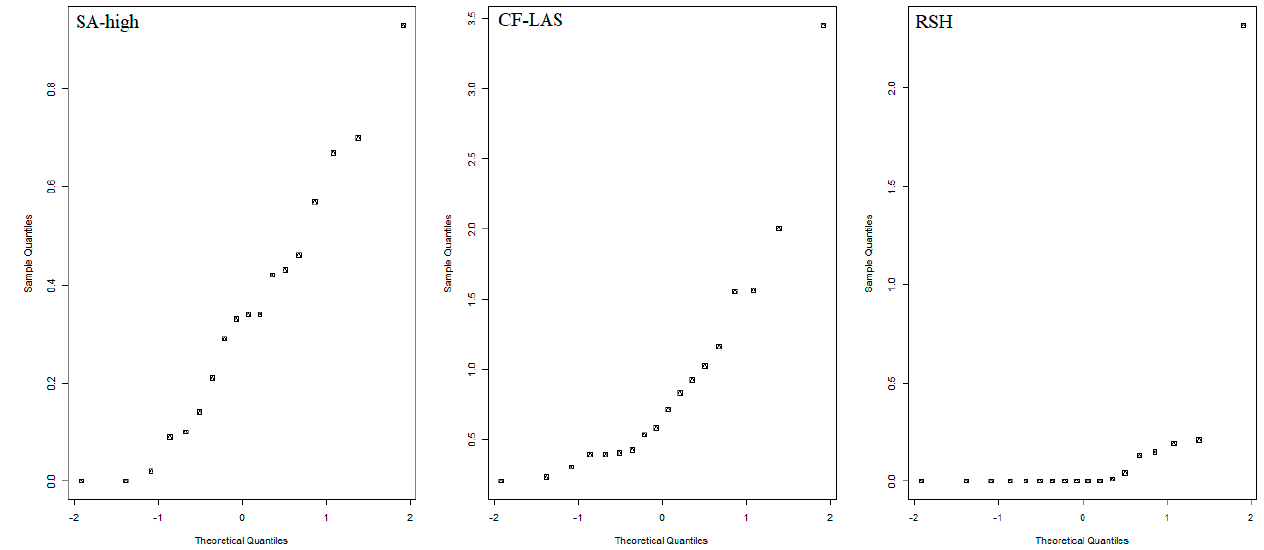
Figure 9. Normality graphs for the three compared algorithms.